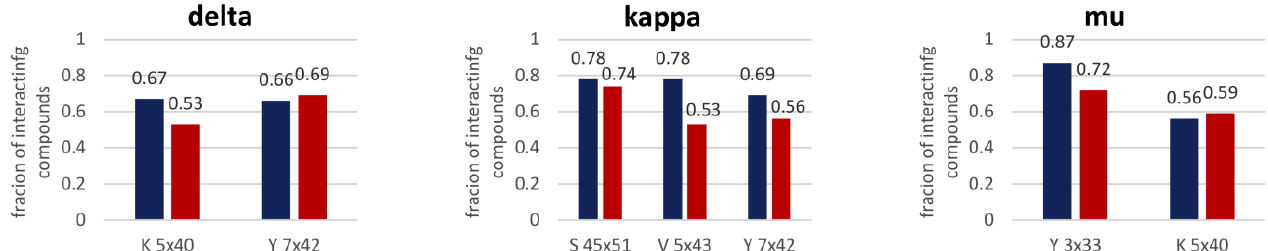
Figure 7. Histograms of the frequencies of interactions of compounds with selected amino acids for compounds with the highest prediction error.